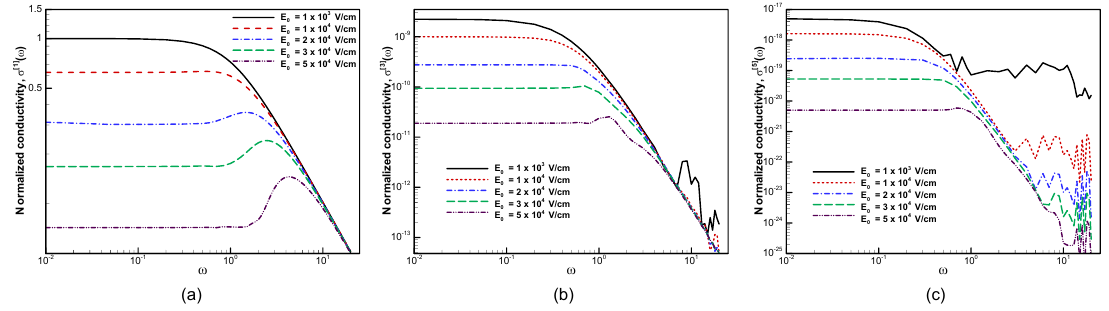
Figure 6. Effect of electric fields on the calculated ( a ) first order, ( b ) third-order, and ( c ) fifth-order conductivity at β = 50, µ = − 0.8, and τ = 1. All conductivities are normalized to low-field, zero frequency conductivity. The peaks appearing at frequencies increasing with electric field are the Bloch oscillation